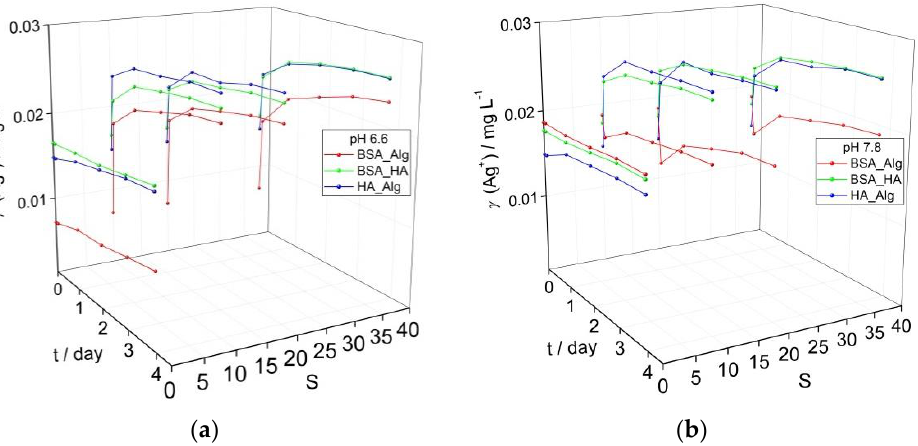
Figure 3. Evolution of calculated Ag + ion concentration based on intensity of the SPR absorbance in media with low oxygen saturation (50%) for dispersions of AgNP coated with combinations of NOM (BSA, HA and Alg concentrations of 10, 10 and 1 mg L −1 , respectively) at ( a ) pH 6.6, and ( b ) pH 7.8 as a function of salinity (S·0-38).